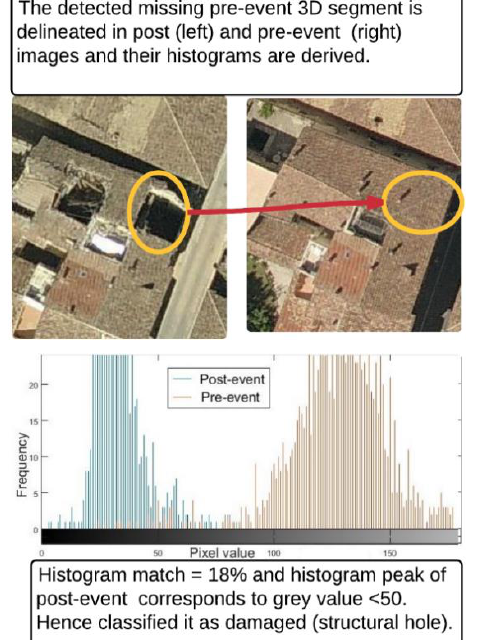
Figure 6. Example for missing 3D segment classified as (structural hole) caused by damage.